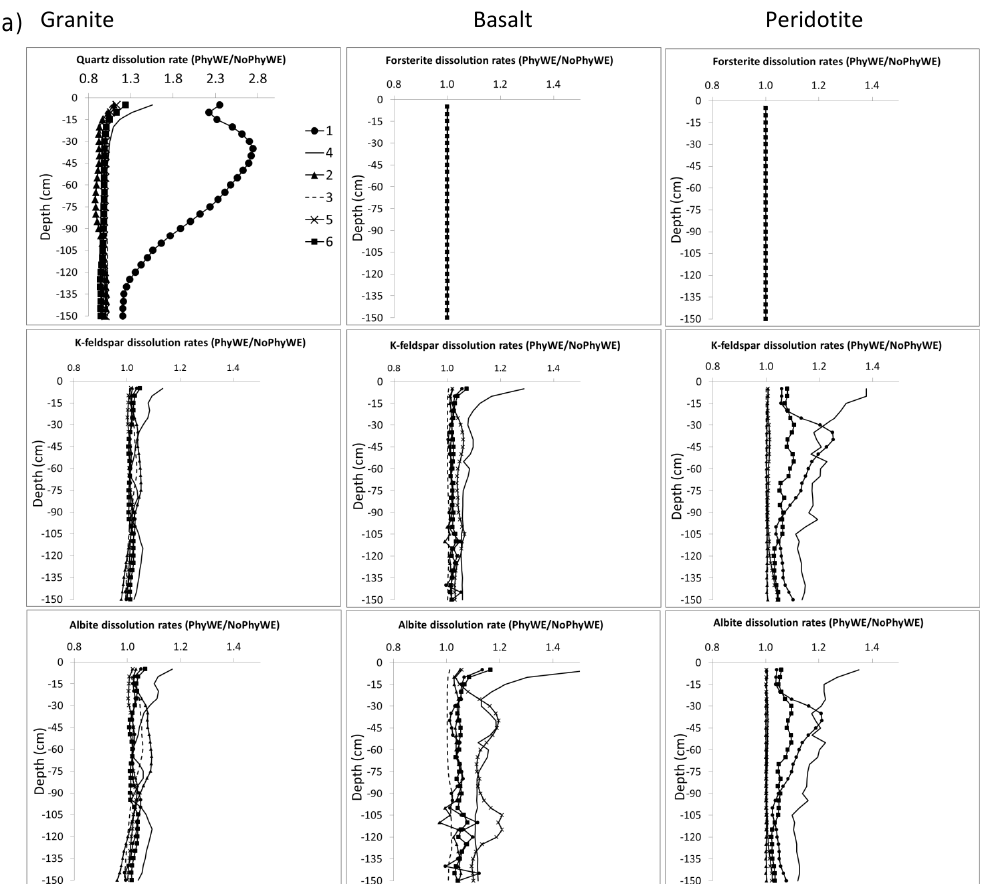
Figure 6. (a) Effect of physical weathering on silicate mineral dissolution rates (Model A). Dissolution rates are presented here as a ratio of physical weathering to no physical weathering (i.e., PhyWE/NoPhyWE). Values greater than one imply that the rates are higher when physical weathering is allowed. Roman numerals 1–6 represent texture numbers presented in Table